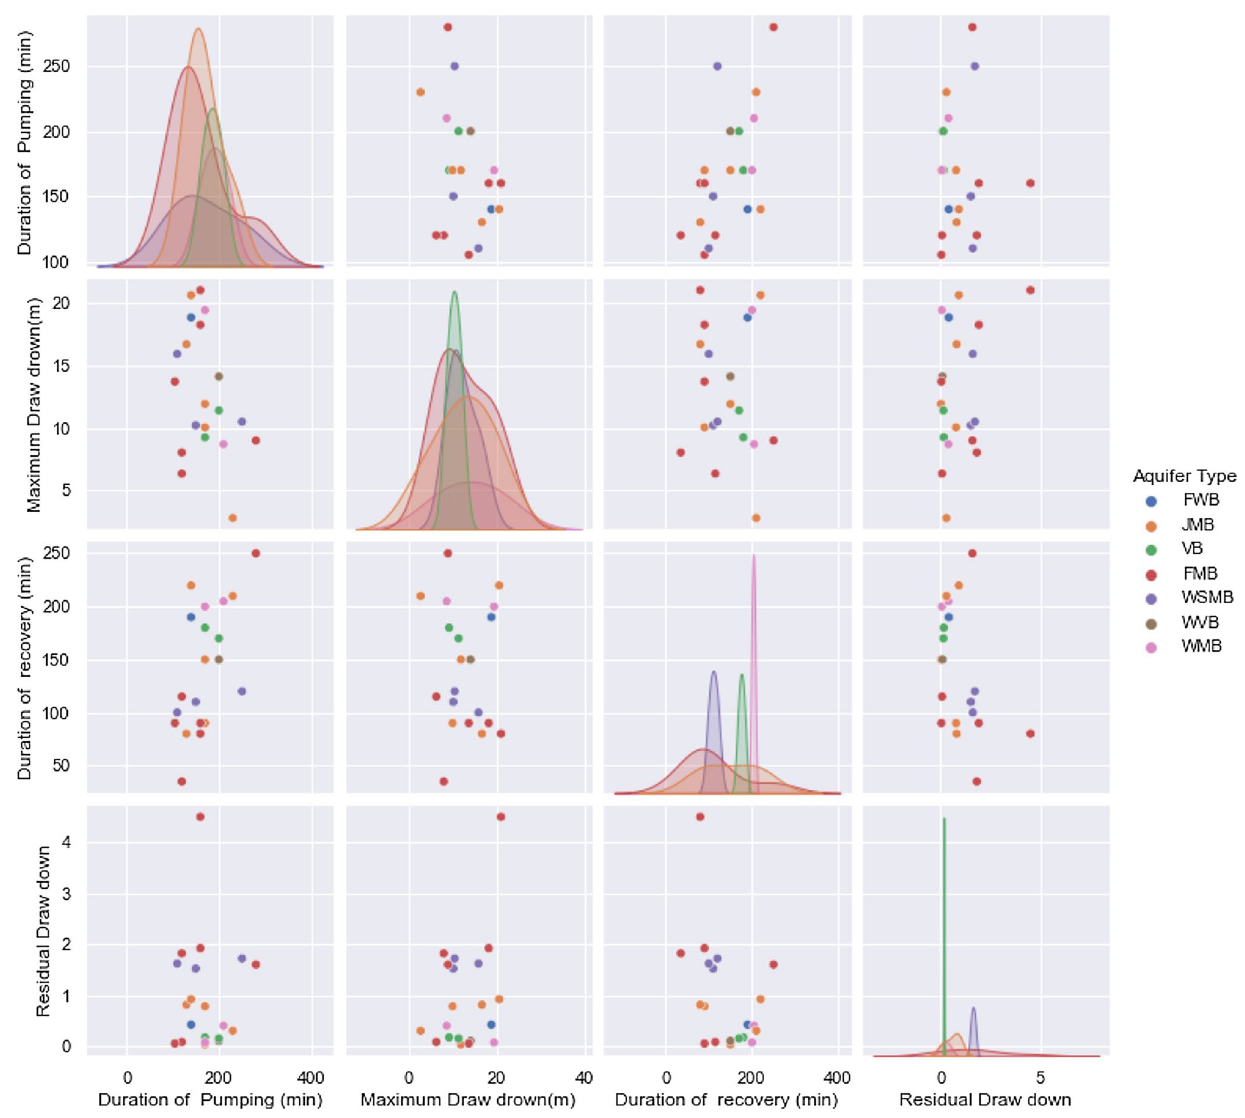
Fig. 31 Pair plots of aquifer